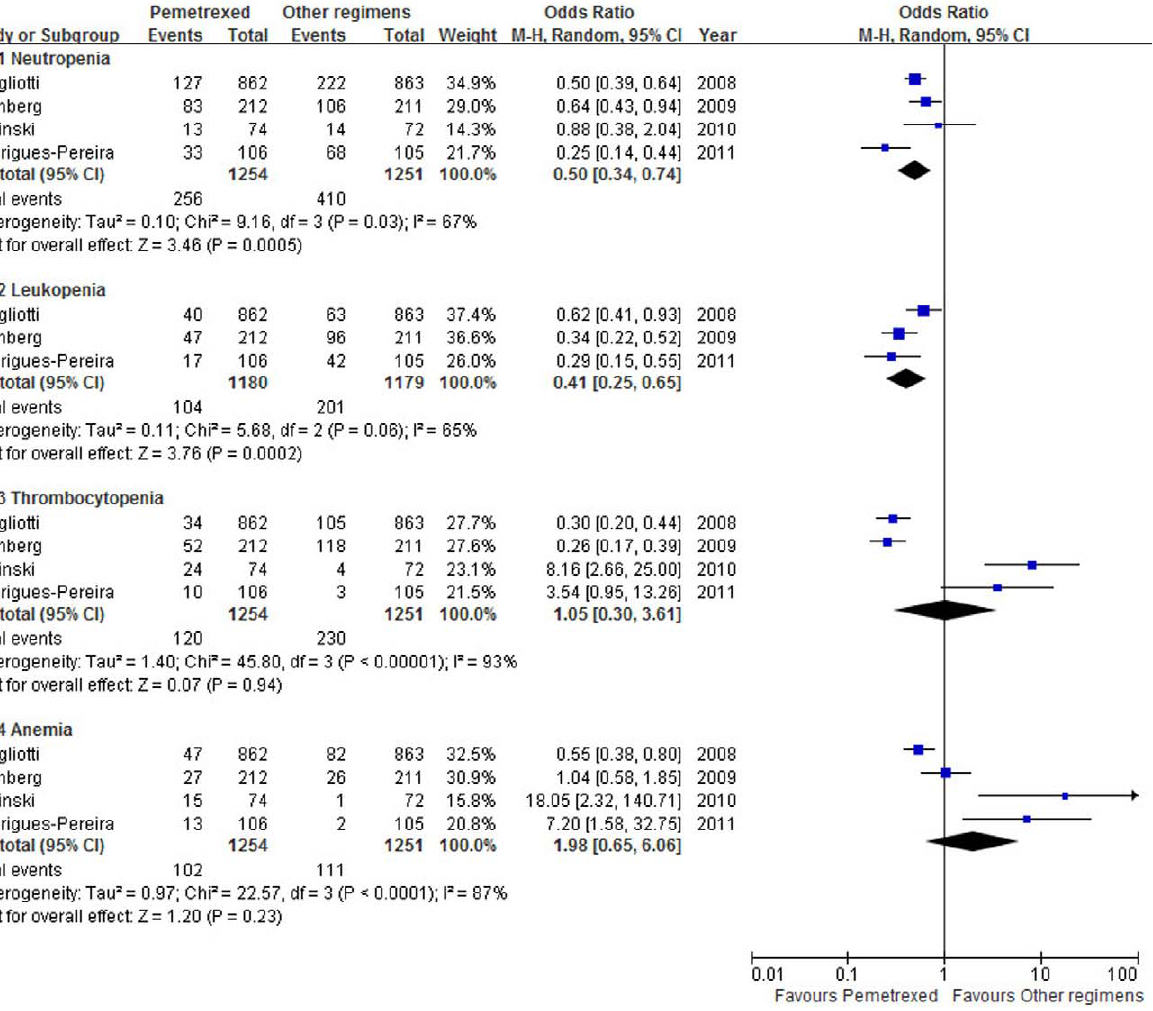
Figure 6. Summary of grade 3–4 hematological toxicity. Abbreviations: M-H, mantel-haenszel; CI, confidence interval.